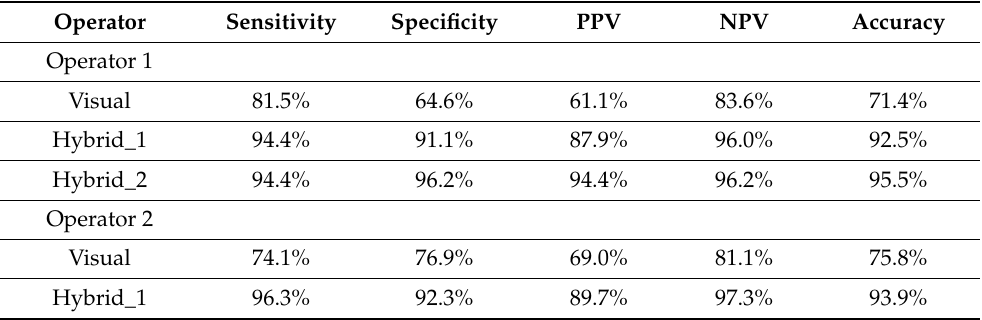
Table 4. The statistics for each individual operator decision, majority vote, top three operators and the hybrid approach concerning revascularization versus the golden-standard fractional-flow